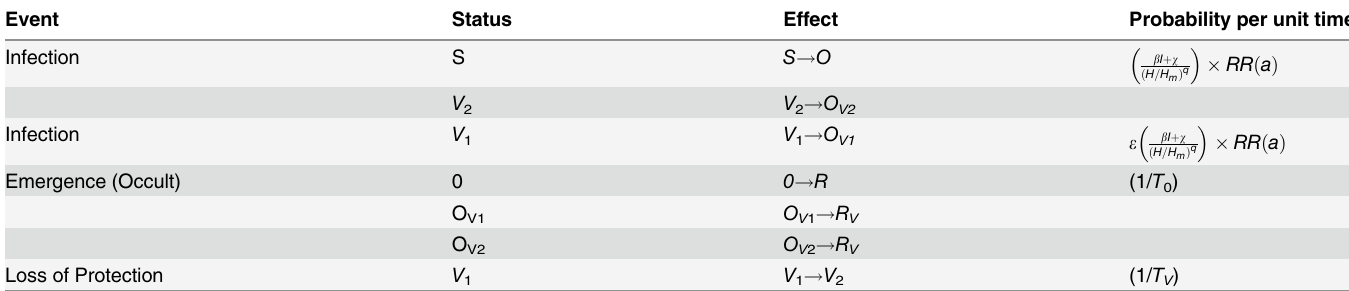
Table 8. Markov events for SOR(V) stochastic transmission model.